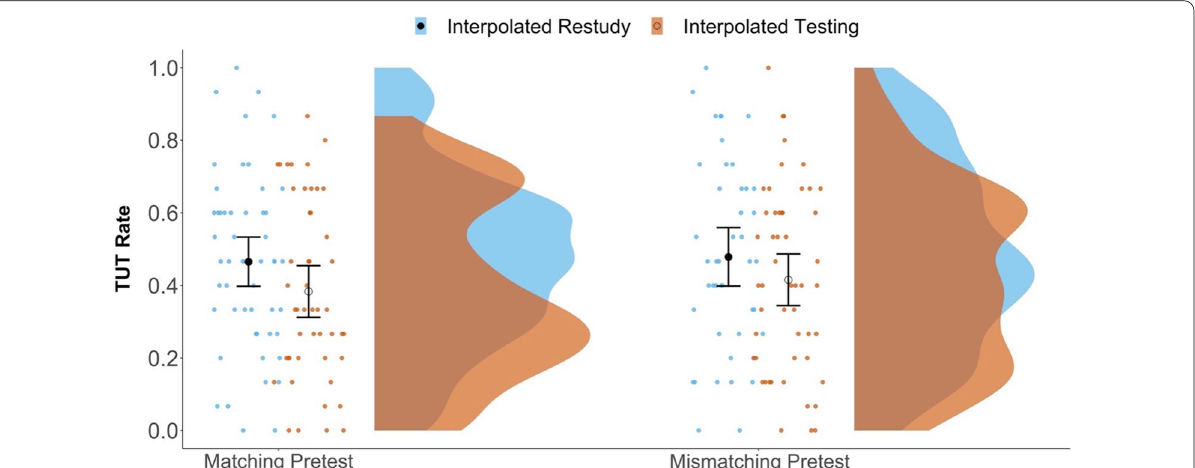
Fig. 3 Raincloud plots depicting TUT rates (the proportions of thought reports indicating TUTs) in each condition. Dots represent individual subjects’ TUT rates. The closed black dots represent group-level mean estimates for the Restudy conditions; open circles represent the group-level mean estimates for the Testing conditions. Error bars are 95% confidence